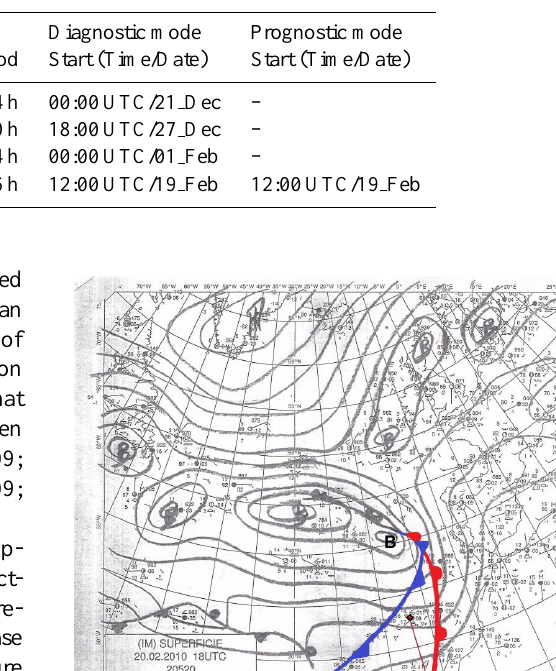
Table 2. Simulation dates and main features for each case.